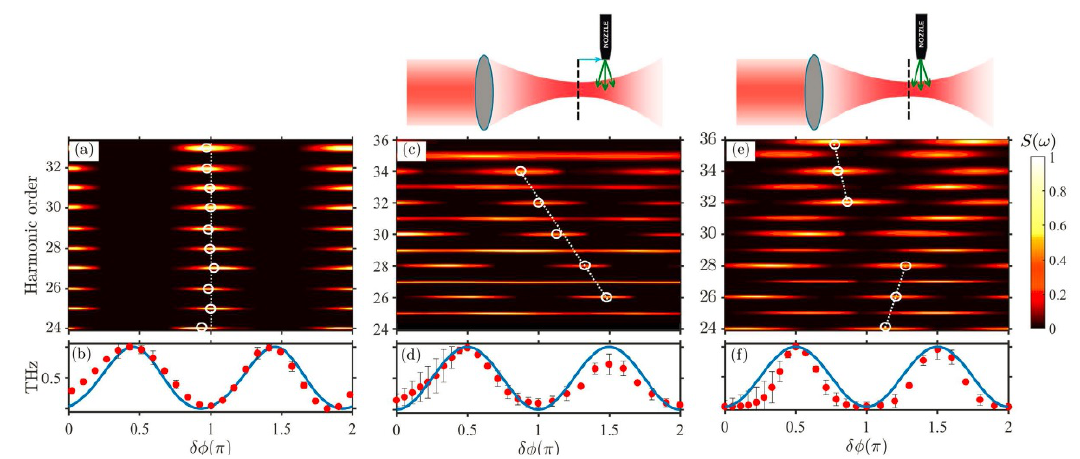
Figure 4. The modulations of high harmonics and THz yields with strong second harmonic (intensity = 0.1 ( a,b )) and weak second harmonic ( A 2 ratio about A 2 / A 2 2 1 of ( c,d ) is for phase-matching condition of the gas jet, while the gas jet is positioned closer to the focus of the laser in ( e,f ). Reproduced with permission from [59]. Copyright Springer Nature Publishing,